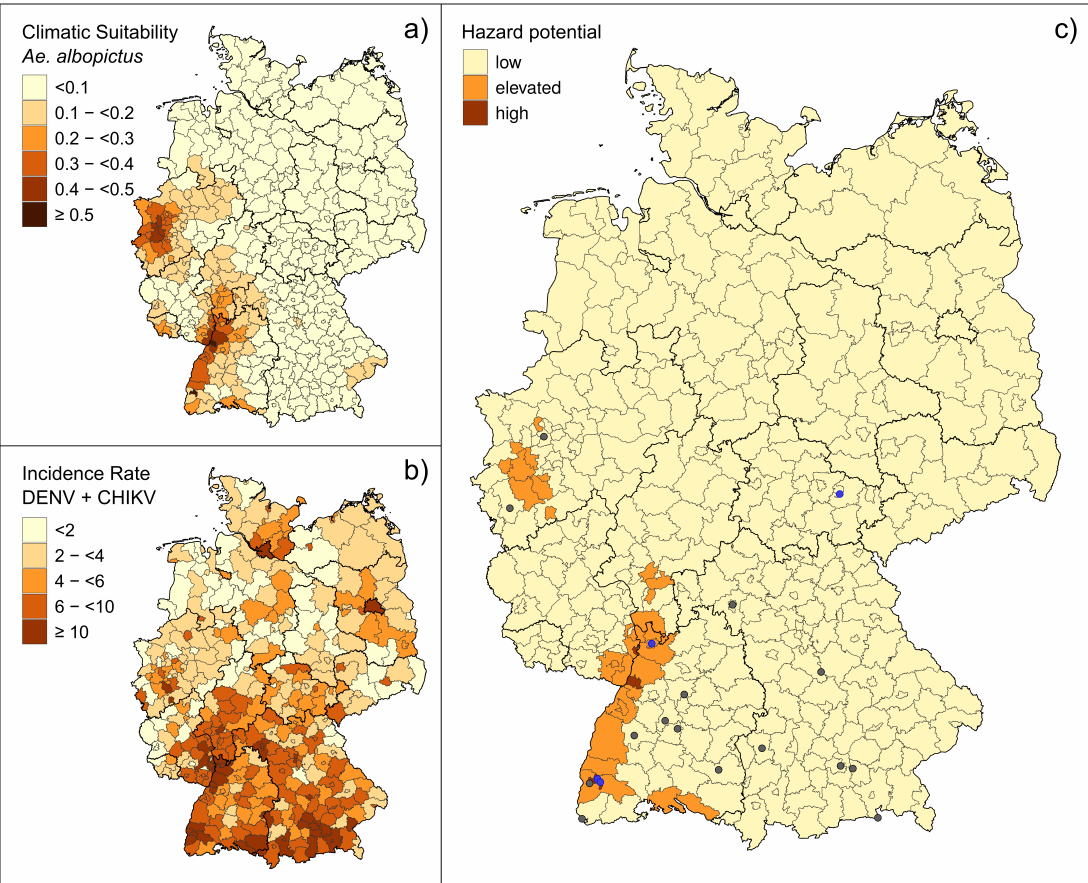
Figure 3. ( a ) Current climatic suitability for the establishment of Aedes albopictus in Germany, averaged over the county level in Germany. ( b ) Incidence of (potentially viraemic) travel-associated CHIKV and DENV infection cases at the county level (cases per 100,000 population by county over the years 2011–2017, from the RKI-hosted national-level database on notifiable diseases SURVNET). ( c ) Likelihood of Aedes albopictus meeting viraemic returning travellers, potentially leading to transmission, shown as a combination of the modelled climatic suitability for Aedes albopictus at the county level, and DENV and CHIKV incidence in returning travellers. Circles: high-precision occurrence records derived from the literature for both single introduction events (grey) and established (overwintering) populations (blue) of Aedes albopictus ; only the latter were used for modelling. Black and grey lines respectively indicate level-2 and level-3 administrational units (federal states and “Kreis”) of Germany. Administrative units provided by the Federal Agency for Cartography and Geodesy in Germany BKG: GeoBasis-DE / BKG